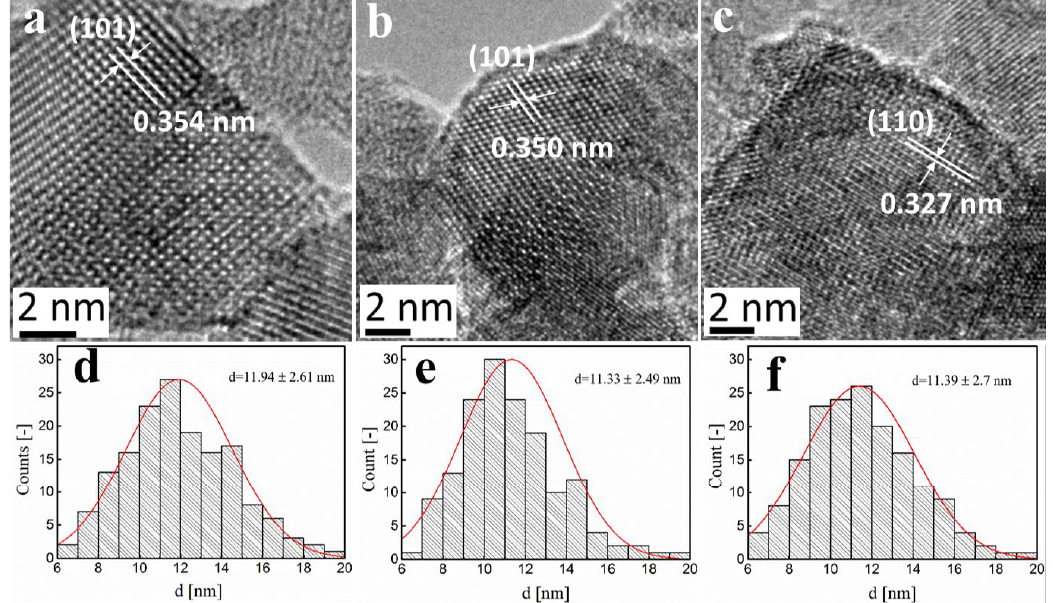
Figure 4. HRTEM images and particle size distribution for samples with an Fe/Ti ratio of: ( a, d ) 0%, ( b, e ) 3%, and ( c, f ) 10%.